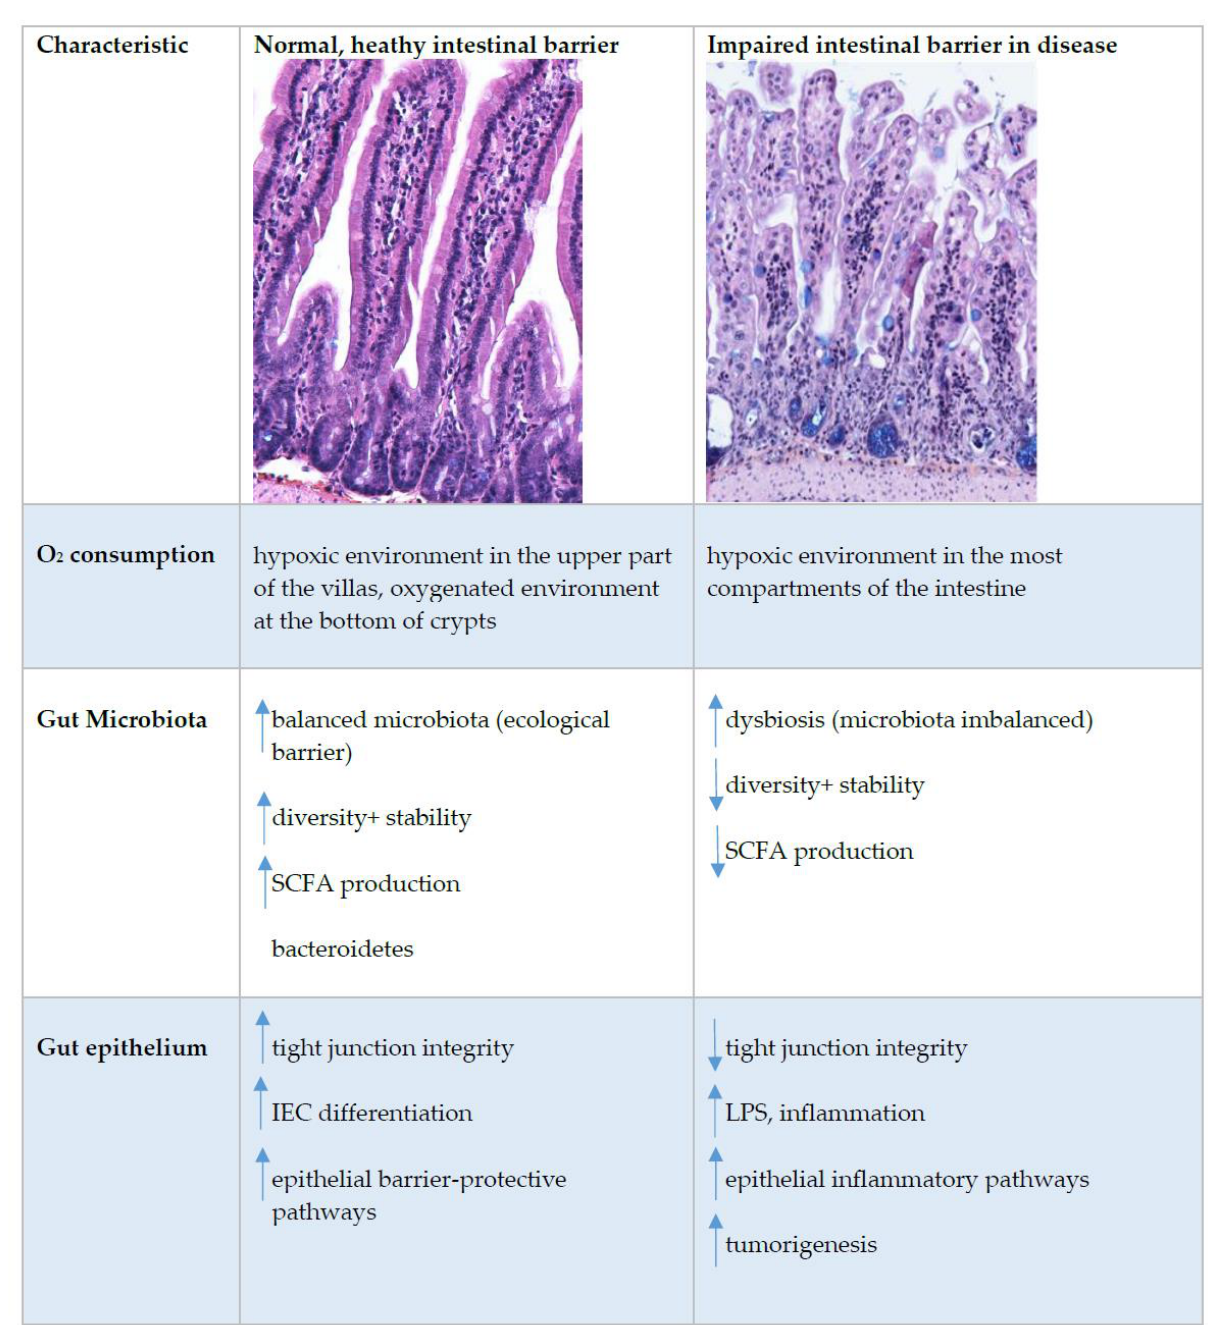
Figure 3. Intestinal epithelial barrier in health and disease. This figure shows immunohistochemistry picture of small intestine crypts–villus axis in healthy and impaired intestine in BALB/cOlaHsd mice and highlight the main characteristics where the differences at the healthy or impaired (in disease) intestinal barrier were detected. Up and down arrows indicate an increase and decrease, respectively. Abbreviations: IEC, intestinal epithelial cells; LPS, lipopolysaccharide; SCFA, short-chain fatty acids; TJ, tight junctions.